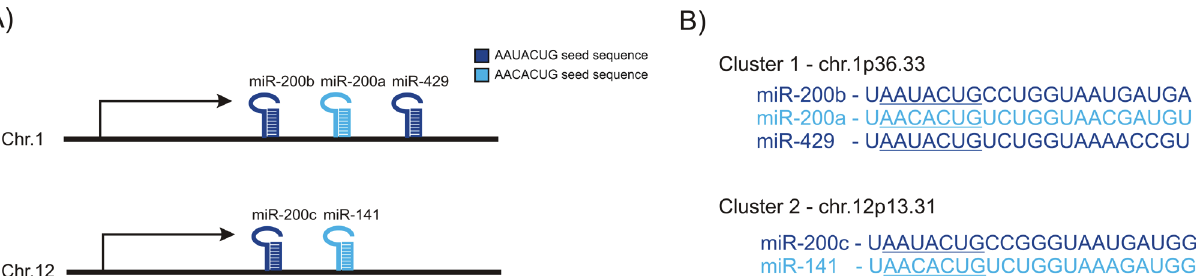
Figure 1. Genomic location and base sequence of the miR-200 family. ( A ) The miR-200 family is located on two distinct clusters on chromosome 1 and 12; ( B ) Sequences of the miR-200 family. The miR-200 family is divided in two functional groups by their seed sequence: miR-200a/141 and